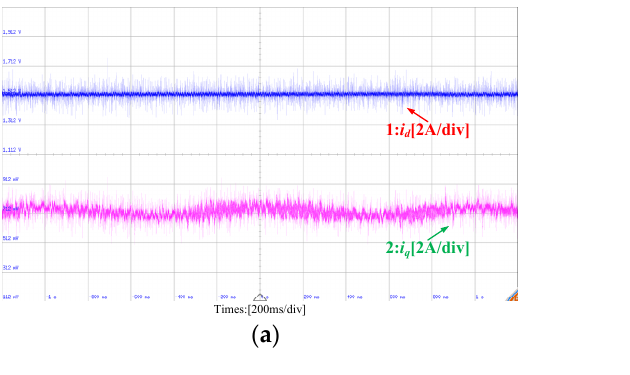
Figure 12. Steady-state experimental waveforms of the d-q-axis current: ( a ) 300 rpm at 2 N / m ( 1: 𝑖 (cid:3031) [2 A/div], 2: 𝑖 (cid:3044) [2 A/div]); ( b ) 500 rpm at 2 N / m ( 1:𝑖 (cid:3031) [2 A/div], 2: 𝑖 (cid:3044) [2 A/div]).